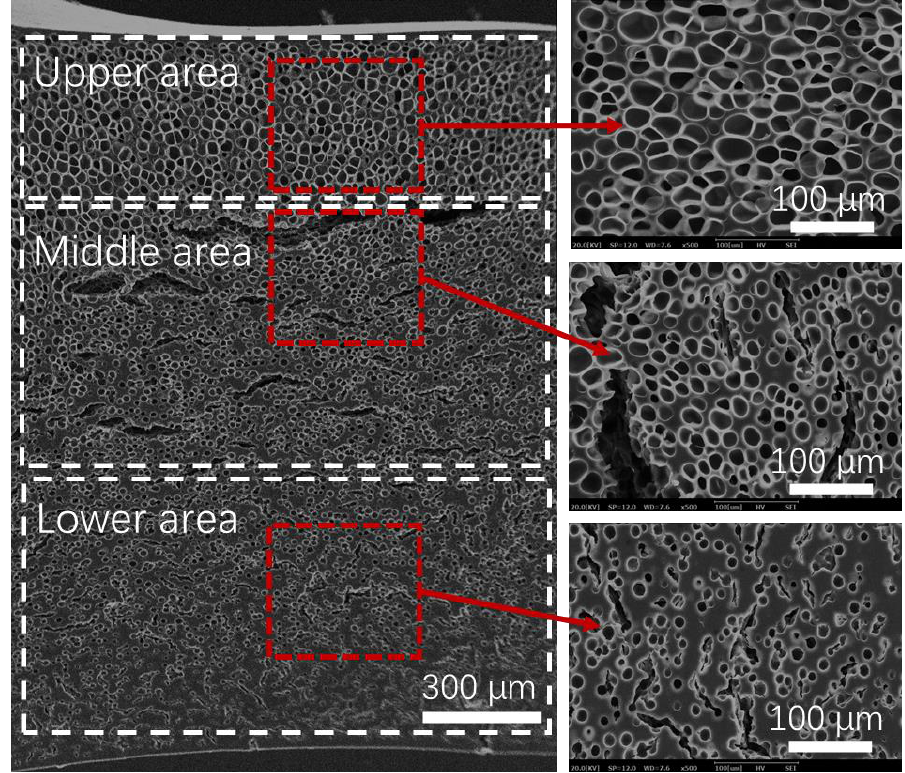
Figure 10. Cell morphologies of HD-TPU foam across the thickness direction. The foam was prepared at 15 MPa/170 °C/30 min.